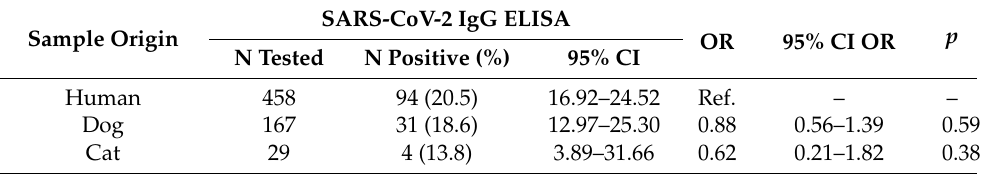
Table 3. Seroprevalence of SARS-CoV-2 in humans and pet animals in Zagreb, December